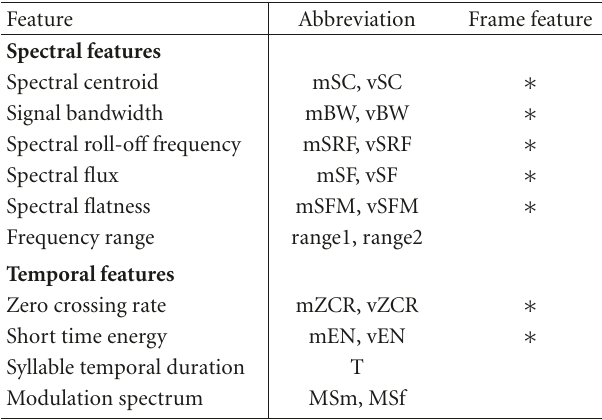
Table 1: Descriptive parameters used in this work. An asterisk ( ∗ ) in the last column indicates that the feature is calculated on a frame- to-frame